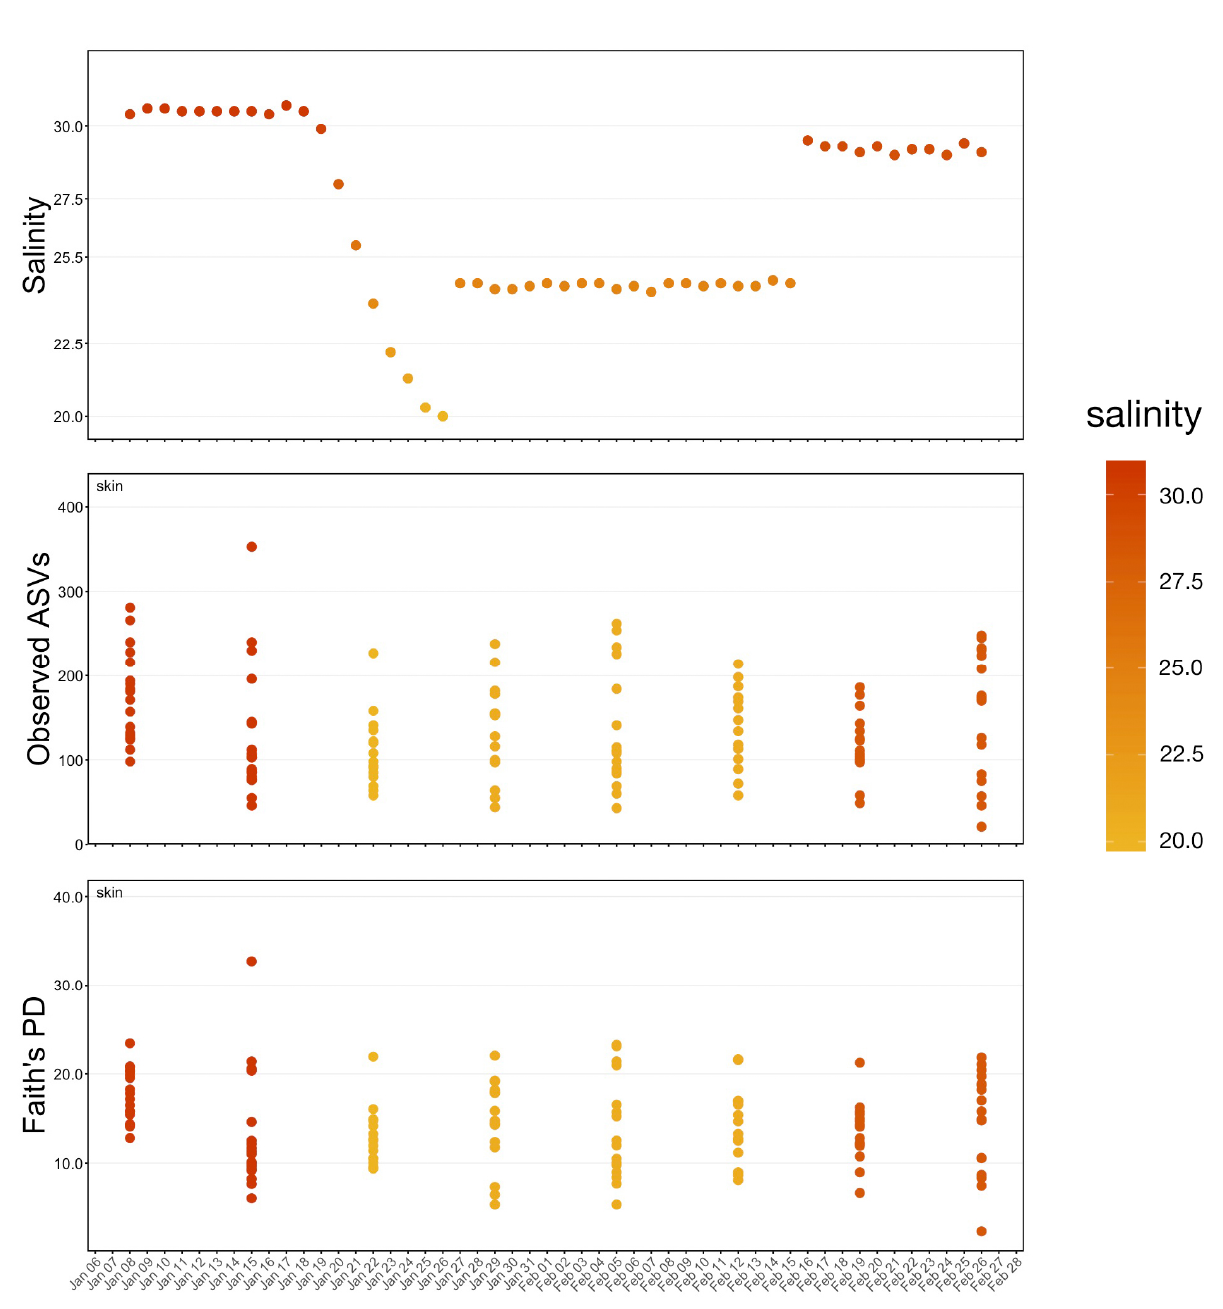
Figure 6. Scatterplot tracking changes on salinity ( top ), richness (Observed ASVs— middle ), and diversity (Faith’s PD— bottom ) in skin community diversity. Points are colored based on salinity values. There were no significant changes in diversity.